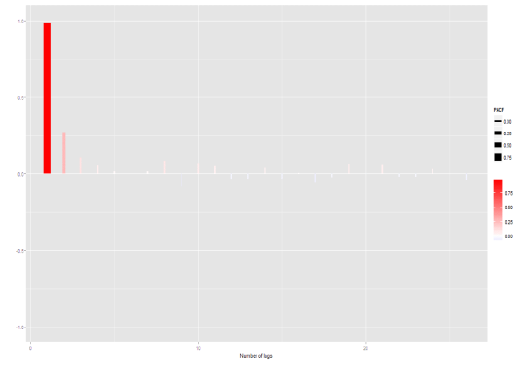
Figure 5 Partial autocorrelation expolarity plot.